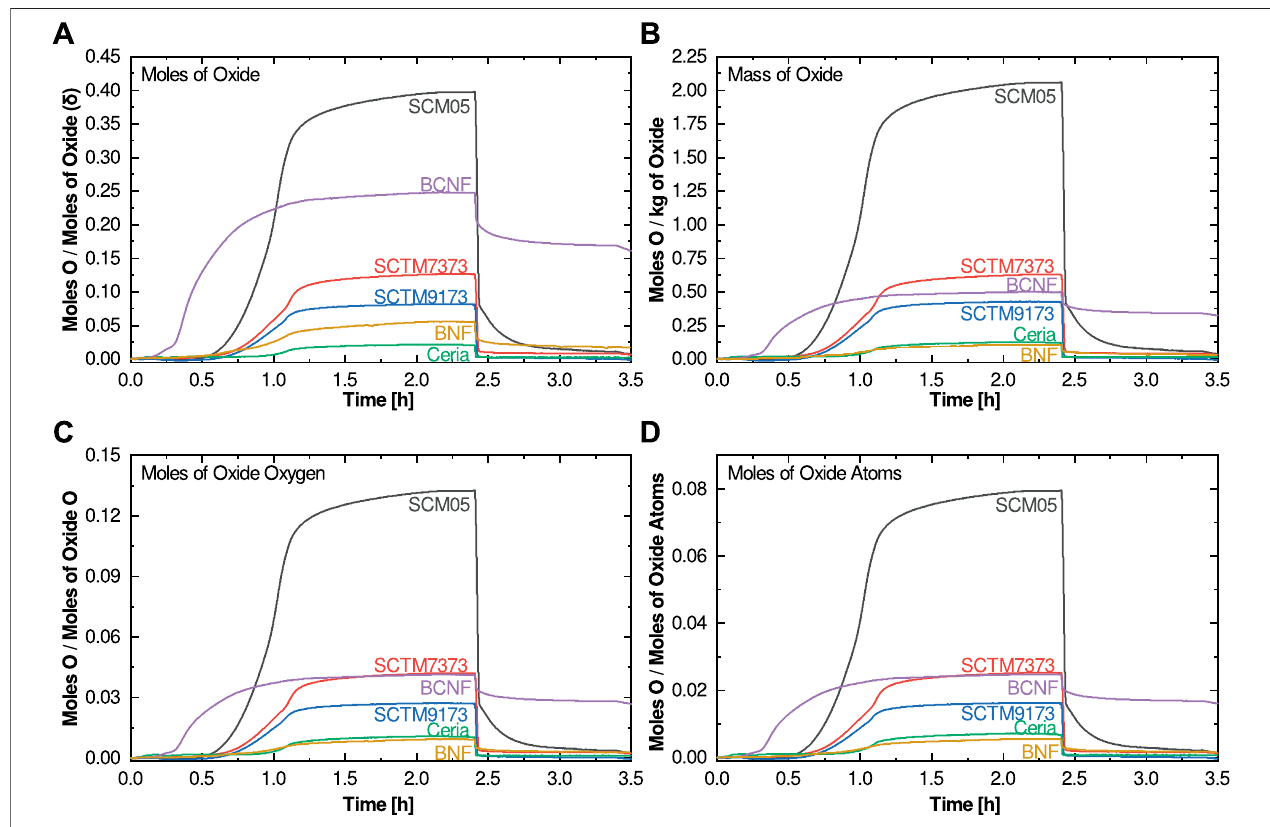
FIGURE 4 | Plots of four different normalization of the TGA data from the TPTR experiments: namely normalization by (A) moles of oxide, (B) mass of oxide, (C) moles of oxide oxygen, and (D) moles of oxide atoms.